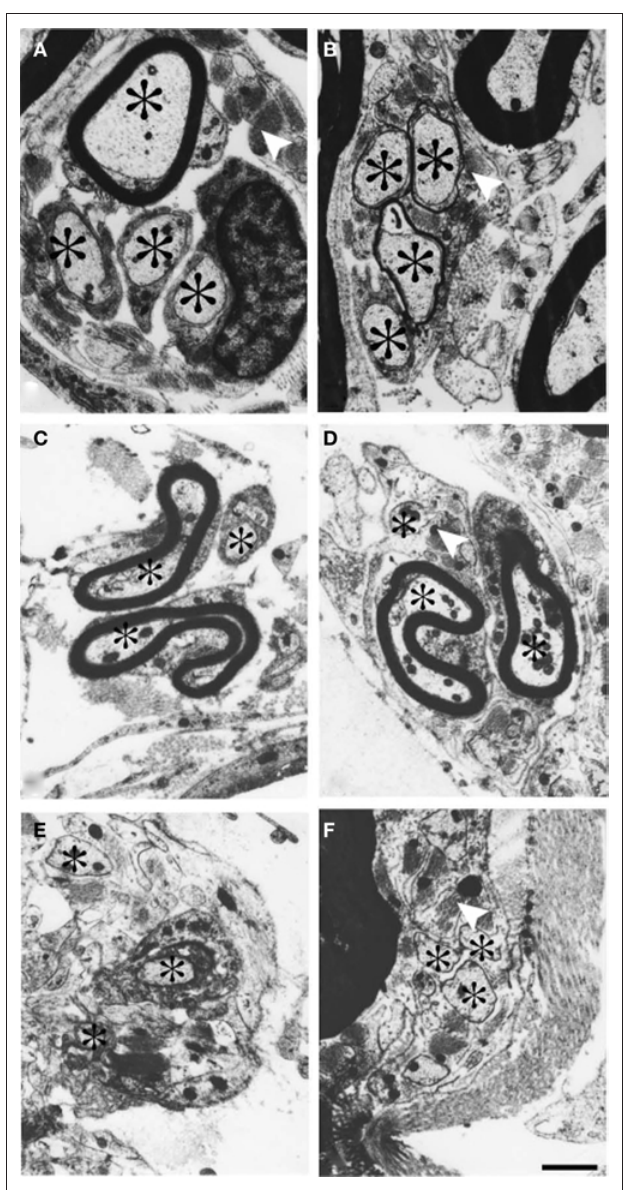
Figure 2 | electron micrographs from a cat surviving for 90 days after sciatic nerve resection. (A,B) A small bundle of axons (asterisk) which was followed in a series of thin sections. At a distal level (A) the axons in the bundle are invested by Schwann cells. A few astrocytic processes are observed in the vicinity. At a more proximal level (B) all the axons in the bundle have entered the CNS compartment of the root fascicle and are surrounded by thin astrocytic processes. The electron micrographs (C–F) show another cluster of axons. At a distal level the bundle was located in the PNS compartment of the fascicle (C) . At more proximal levels the bundle entered the CNS compartment of the fascicle and becomes surrounded by astrocytic processes (indicated by white arrowheads) (D–F) . Scale bar = 1 μm.